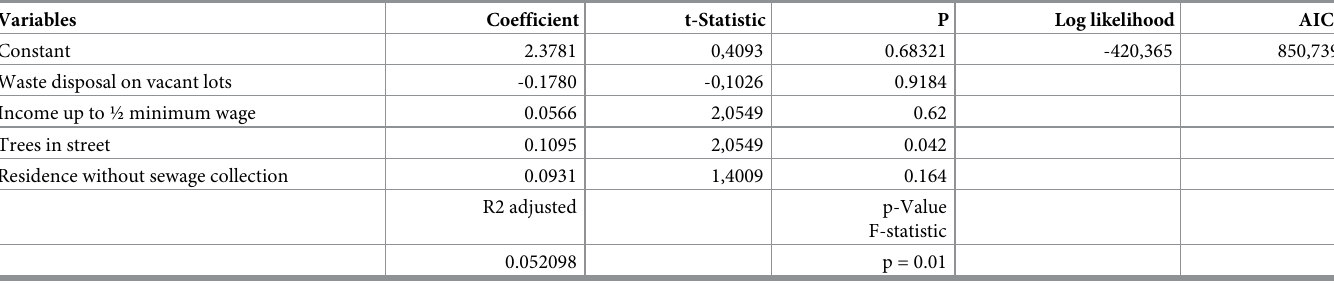
Table 5. Ordinary Least Squares (OLS) Regression of leishmaniasis incidence rates in the urban area of Caratinga. Variables